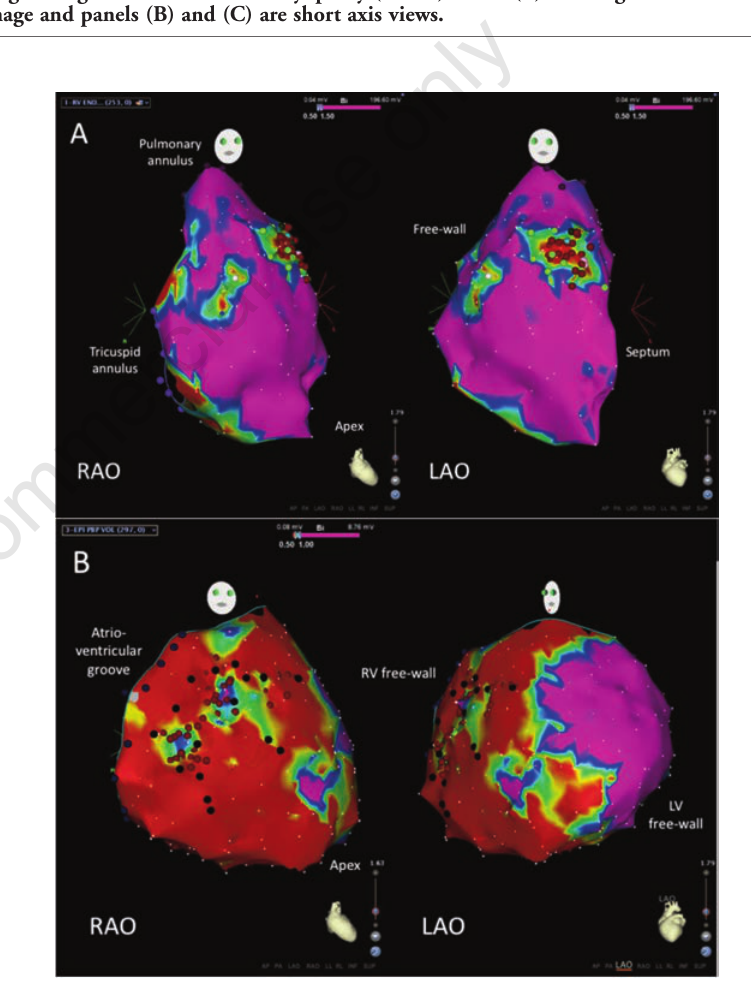
Figure 4. Endocardial and epicardial voltage mapping. Panel (A) shows right ventricular endocardial bipolar voltage maps in the right anterior oblique (RAO) and left anterior oblique (LAO) views from a 22-year-old patient with arrhythmogenic right ventricular cardiomyopathy (ARVC) and ventricular tachycardia refractory to amiodarone. Panel (B) shows epicardial bipolar voltage maps from the same views. Purple reflects healthy myocardium and red reflects severely scarred myocardium or epicardial fat. Note the patchy endocardial scar but more extensive epicardial scar. The black or green markers indicate late potentials (delayed electrical activity within the scar). The red markers are ablation lesions performed during the